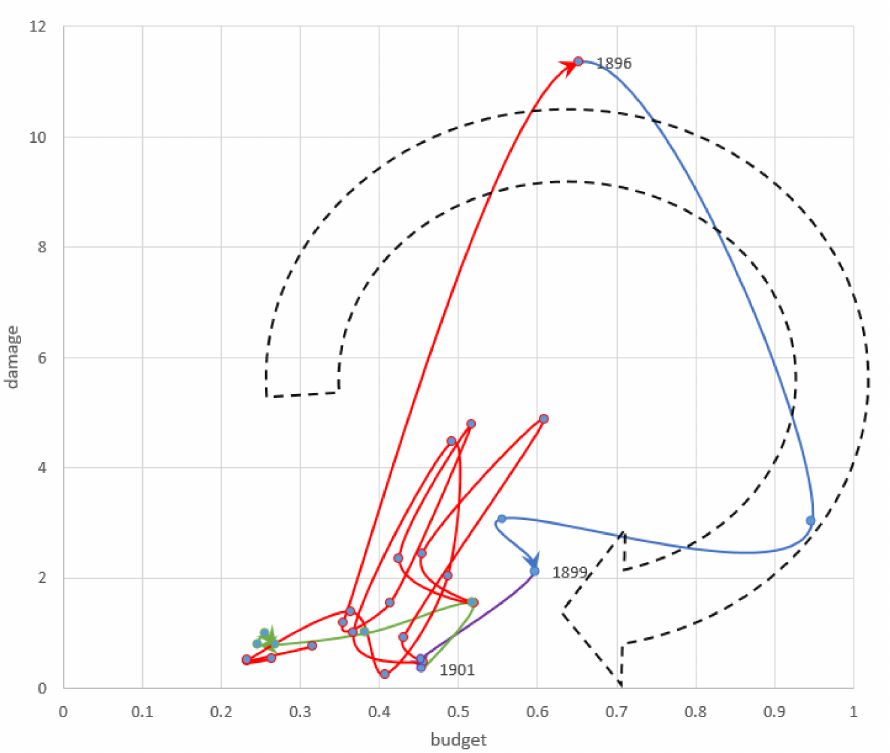
Figure 2. First investment cycle 1878–1906 (Share of the National Income %). Source: Authors’ elaboration. Increasing Budget